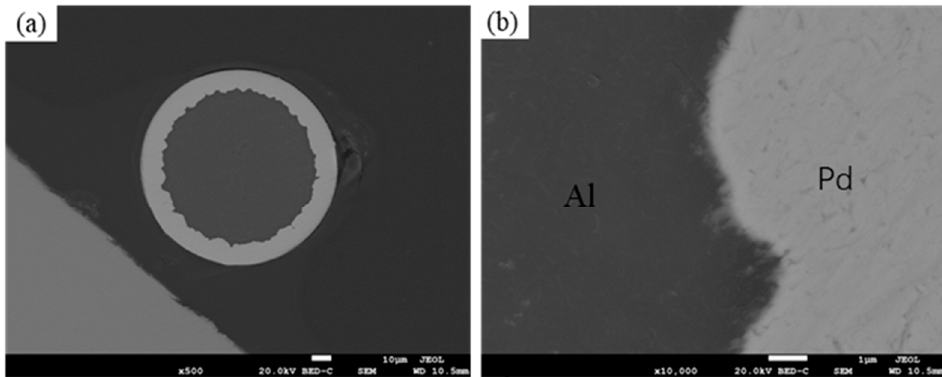
Figure 1. SEM images of Pd/Al composite wire: ( a ) ×500, ( b ) ×10,000.